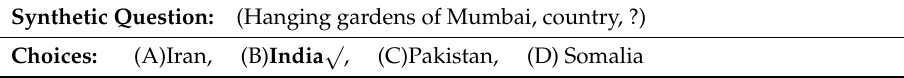
Figure 14. An example of synthetic style question. The passage and question are taken from the Qangaroo [51] dataset.